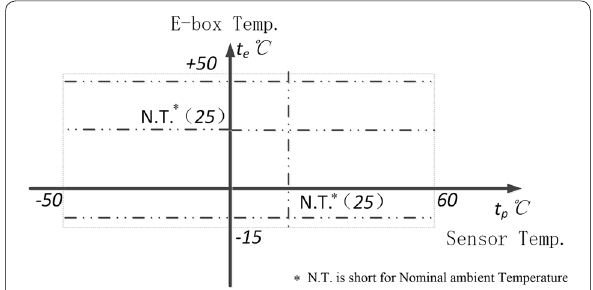
Fig. 7 The temperature setup (dot and dash lines) for four sets of thermal drift calibration tests, see in figure. N.T. means nominal ambient